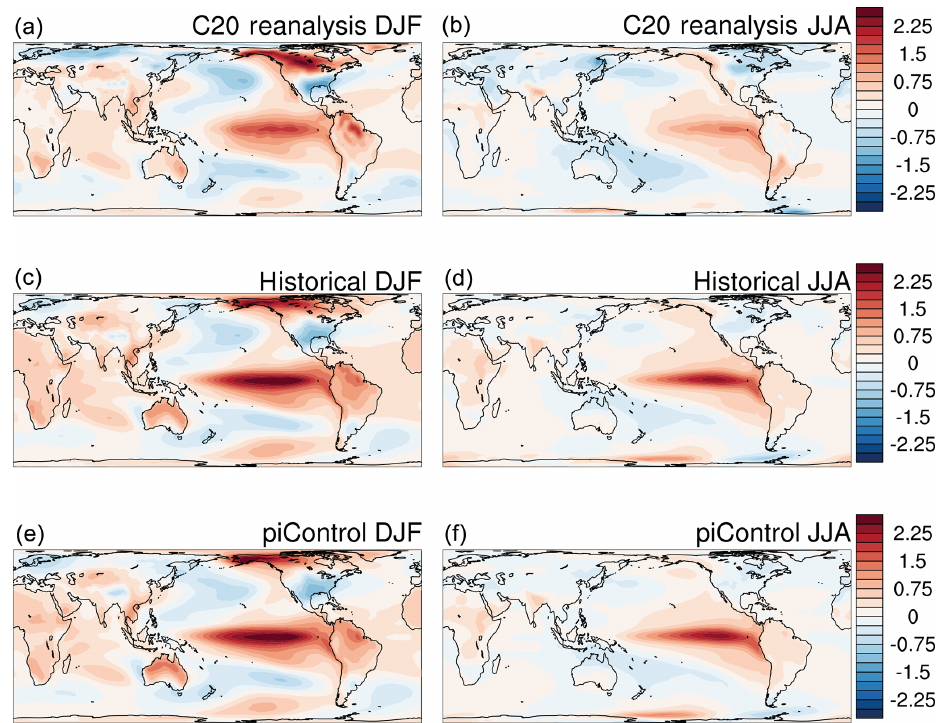
Figure 4. Evaluation of the ENSO temperature teleconnections. Composite El Niño minus La Niña surface temperature anomaly from (a) DJF and (b) JJA from the C20 reanalysis (Compo et al., 2011) between 1871 and 2010, (c) DJF and (d) JJA model ensemble mean from the historical simulations between 1850 and 2005 (for CMIP5 models) or 1850 and 2015 (for CMIP6 models), and (e) DJF and (f) JJA model ensemble mean from the pre-industrial control simulations. Units are ◦